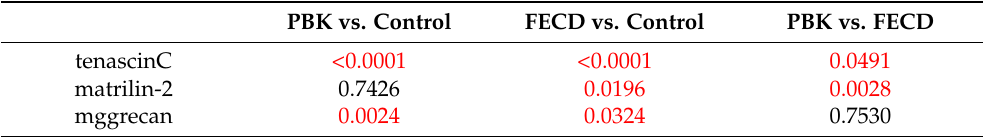
Table 9. Comparison of cumulative immunopositivity of corneal layers in control and diseased groups regarding to tenascin-C, matrilin-2 and aggrecan expression. PBK vs. Control FECD vs. Control PBK vs. FECD tenascinC <0.0001 <0.0001 0.0491 matrilin-2 0.7426 0.0196 0.0028 mggrecan 0.0024 0.0324 0.7530